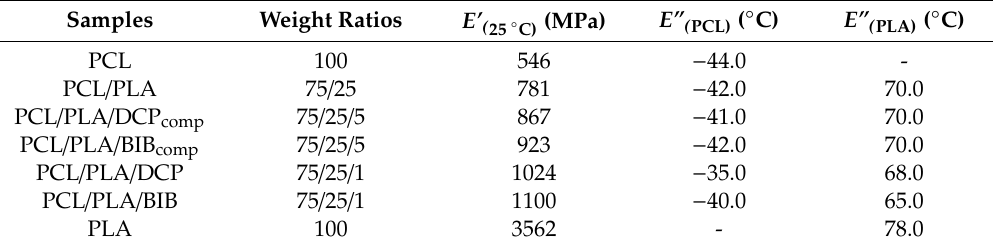
Table 3. DMA parameters of neat PCL, PLA, and PCL / PLA